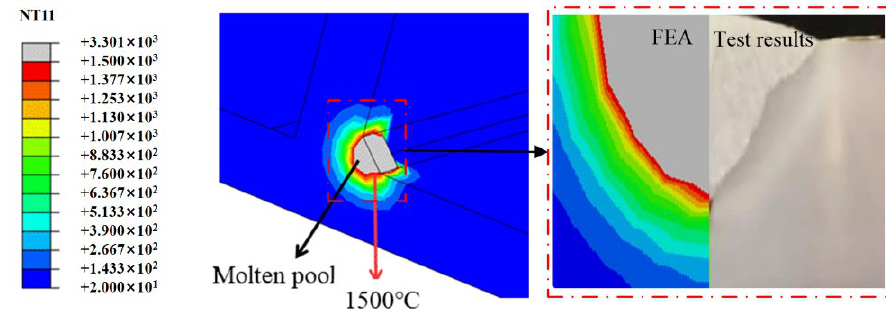
Figure 8. The flow chart of heat source optimization. Table 2. Comparison of welding pool parameters.